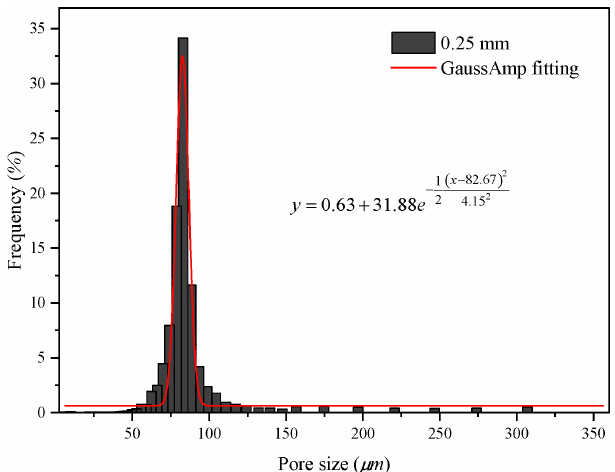
Figure 10. Histogram of the pore size distribution of the permeable stone with a particle diameter of 0.25mm.